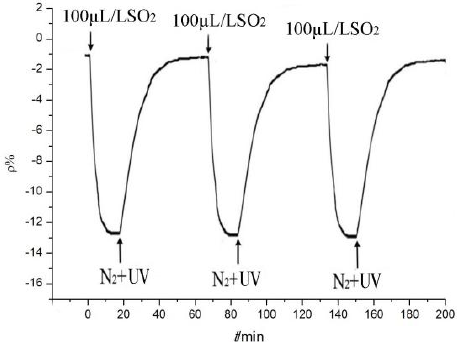
Figure 12. Response and recovery